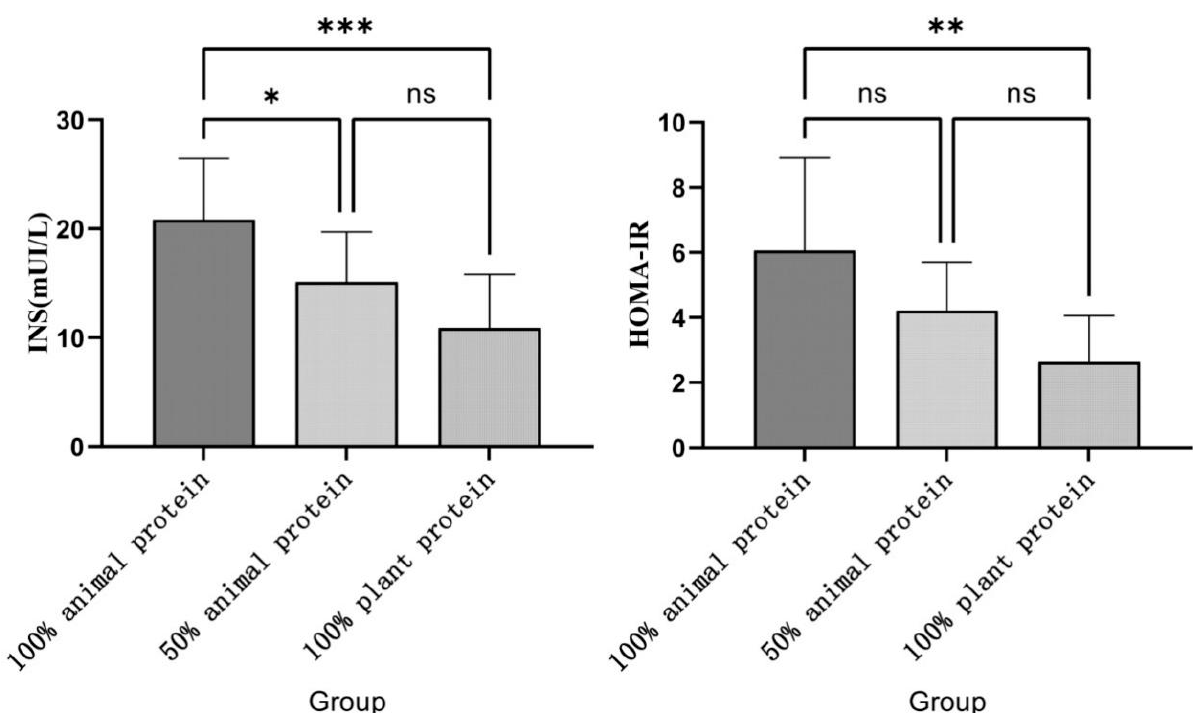
Figure 2. INS and HOMA-IR levels in the three groups. Figure legend: The INS and HOMA-IR levels in the 100% animal protein, 50% animal protein, and 100% plant protein group. Compared to the 100% animal protein group, HOMA-IR and insulin levels were significantly decreased in the 100% animal protein group. At the same time, the insulin level of the 50% animal protein group was also significantly lower than that of the 100% animal protein group. * adjusted p < 0.05; **, adjusted p < 0.01; *** adjusted p < 0.001.